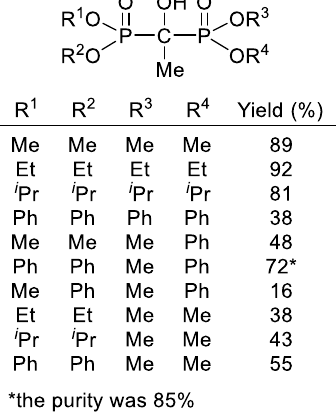
Figure 1. 1-Hydroxyethylidene-1,1-bisphosphonates synthesized by Vepsäläinen et